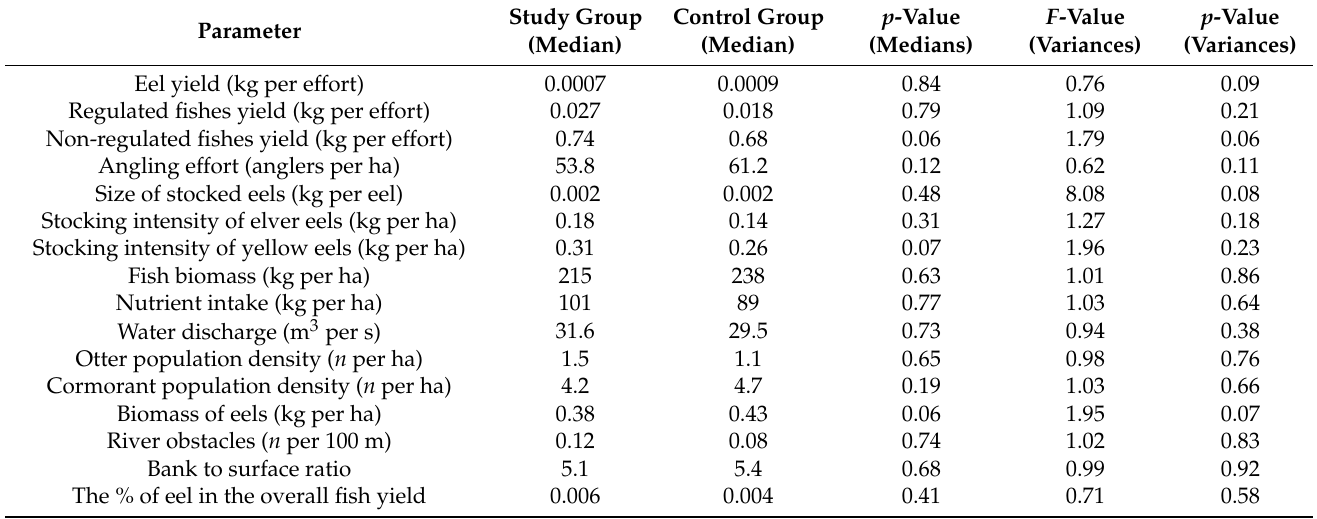
Table 1. The comparison of the important fishery, ecological, and biological parameters between the studied fishing sites (study group, n = 176) and the control group fishing sites (control group, n = 25). The data were collected by the Czech Fishing Union on 176 studied and 25 control rivers stretches over the years 2005–2018. They originate from angling logbooks that were submitted by recreational